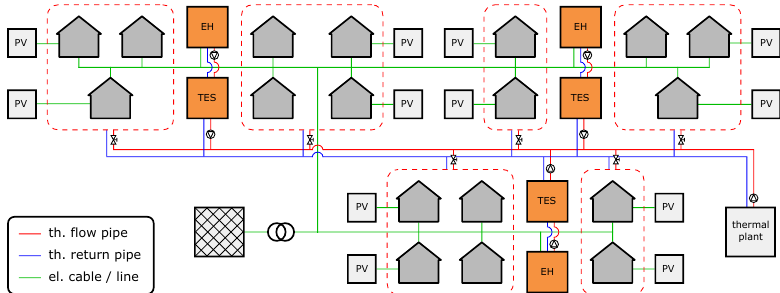
Figure 9. Schematic overview of the hybrid system layout for the rural residential area, depicting the electrical distribution network and the district heating network (EH, electric heater; TES, thermal energy storage). The components targeted by the design optimization process are highlighted in